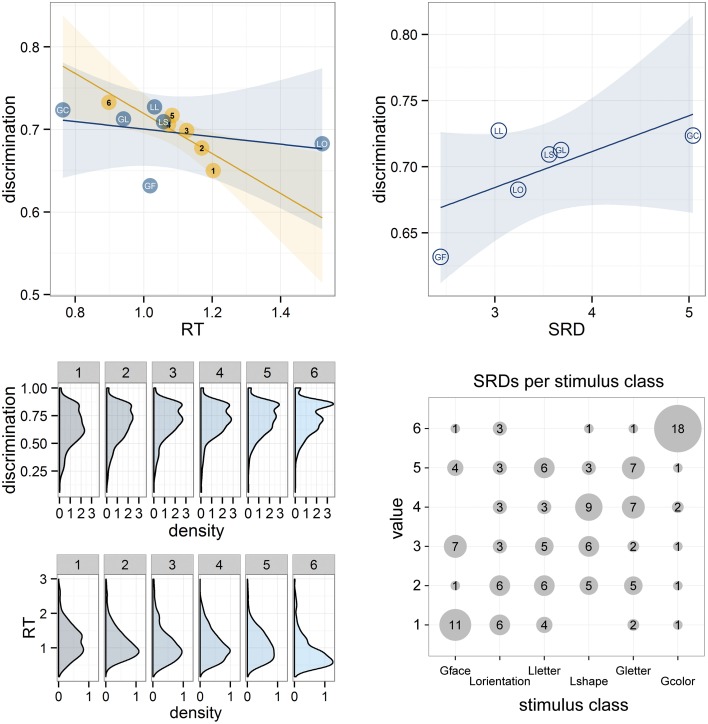
Top left: SRD (self-reported measure of difficulty) classes 1–6 (where 1 = hardest and 6 = easiest) and also target stimulus classes are scatter plotted in the space of d×RT. Target stimulus labels are GF, global faces; GL, global letters; GC, global color; LS, local shapes; LL, local letters; LO, local orientation. Top right: target stimulus classes scatter plotted in the space of d×mean SRD. Each group of points is fitted with a linear regression line with 95% CI band. Bottom left: density plot for six SRD classes of d (above) and RT (below). Bottom right: SRDs assigned to each stimulus class, with classes ranked left to right by average SRD value.